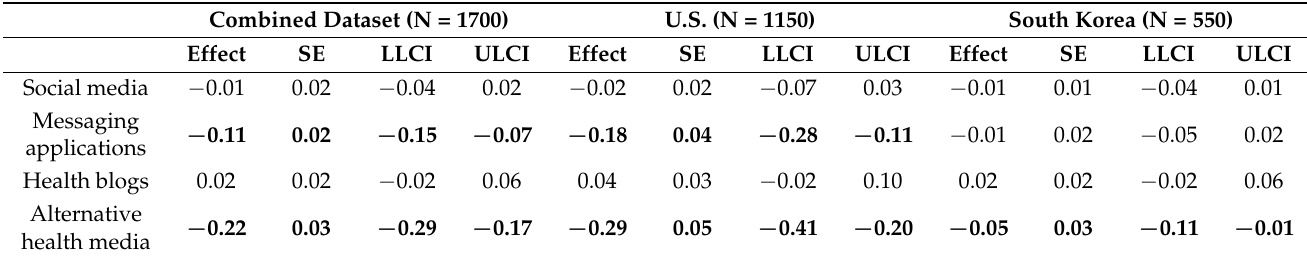
Table 4. The mediation effect of media reliance for COVID-19 news on vaccination